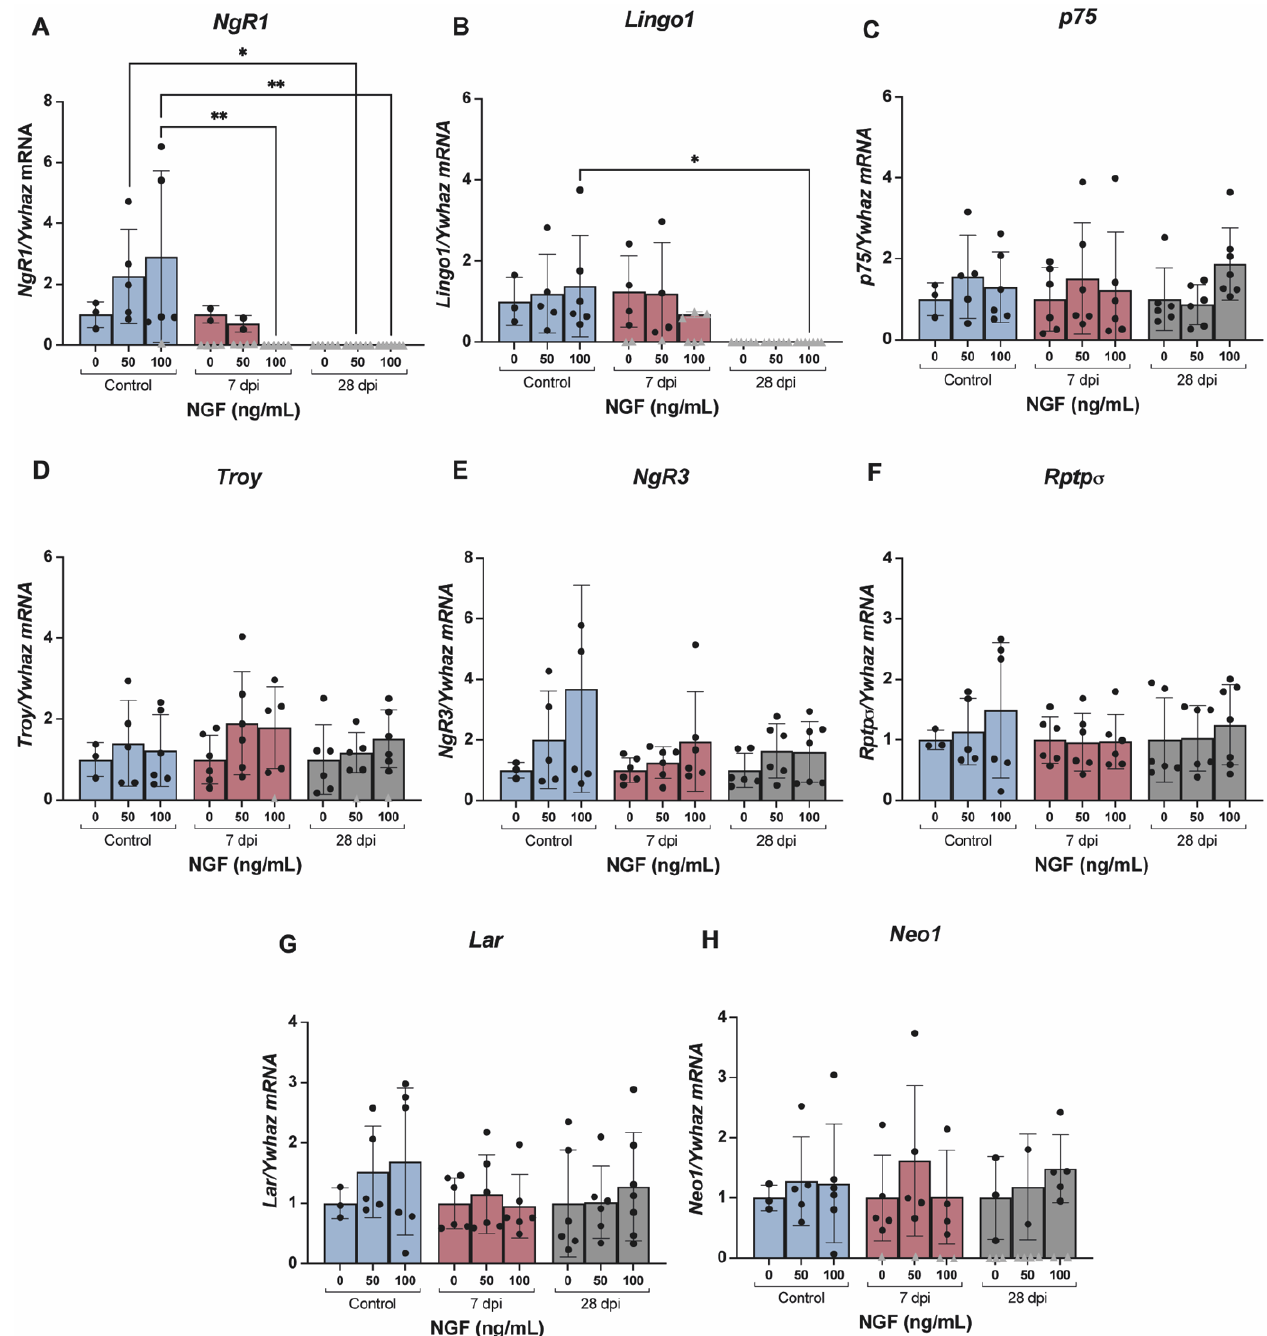
Figure 7. Levels of mRNA of myelin-associated inhibitors (MAIs) receptors NgR1 ( A ), Lingo1 ( B ), p75 ( C ) and Troy ( D ), CSPGs receptors NgR3 ( E ), Rptp σ ( F ) and Lar ( G ) and RGMa receptor Neo1 ( H ) in cultured lumbosacral (L5-S1) DRG cells of spinal intact (control) and SCT animals. Graphs represent mean ± SD and p < 0.05 was considered statistically significant. mRNA levels of NgR1 and Lingo1 significantly decrease 28 dpi (days post-injury), independently of NGF concentration, as amplification was nondetected (represented in the graphs by grey triangles) in these groups. mRNA levels of the other receptors remained unaltered. * p ≤ 0.05; ** p ≤ 0.01; two-way ANOVA followed by Newman–Keuls multiple comparison